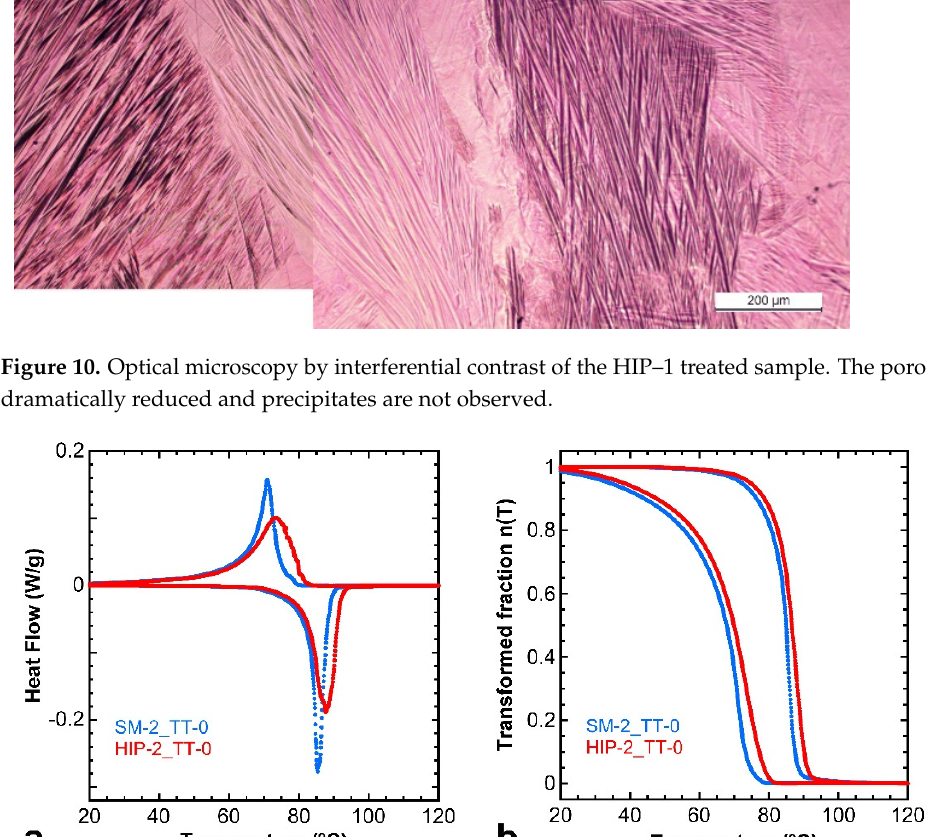
Figure 11. ( a ) DSC thermograms. ( b ) Transformed mass fraction curves. In both figures, the HIP–2 sample (red curves) and the SM–2 sample (blue curves) are compared after undergoing the TT–0 heat treatment.